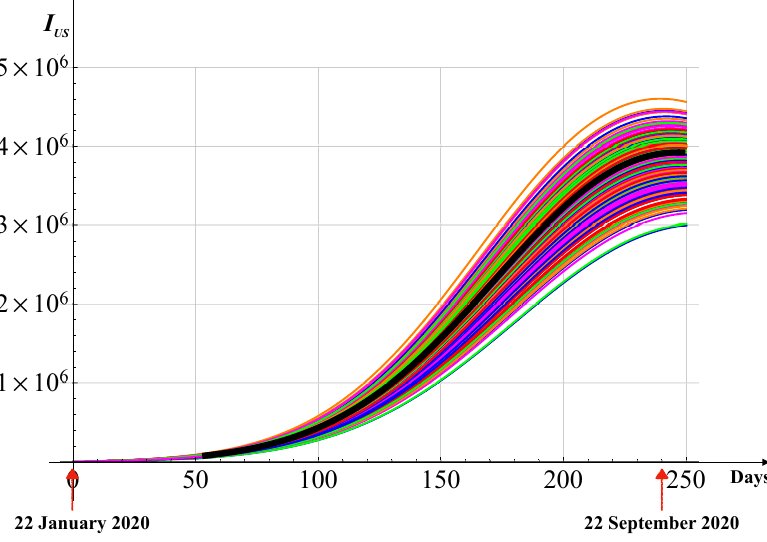
Figure 29. Set of paths (200 realisations) of the stochastic differential equation for USA’s three waves model. The values of the parameters are those reported in Figure 23. The intensity of the noise is ˜ η = 0.0002, which has been obtained by using Equation (65). The black curve is the solution of the deterministic